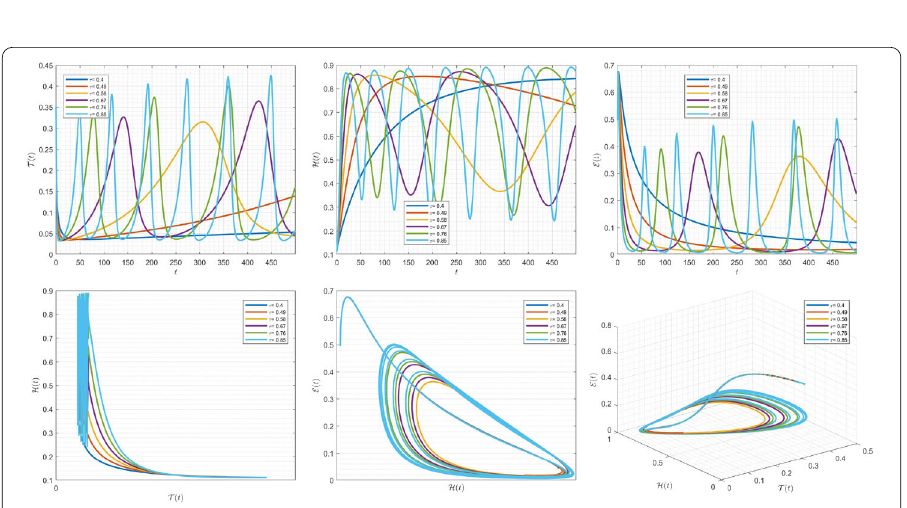
Figure 18 Simulations for solving (75) using (79) along with ( T (0), H (0), E (0)) = (0.3517,0.1115,0.4951) and β 12 =